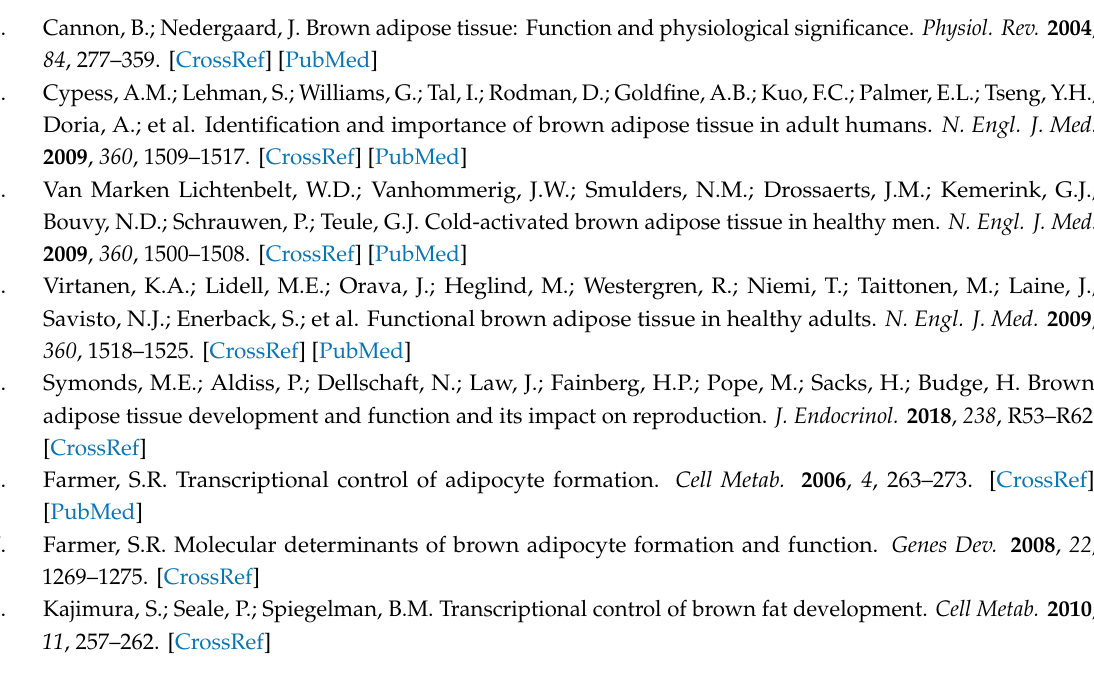
Figure S1: CircRNA analysis of aBATs and neBATs, Figure S2: MicroRNA analysis of aBATs and neBATs, Figure S3: LncRNA analysis of aBATs and